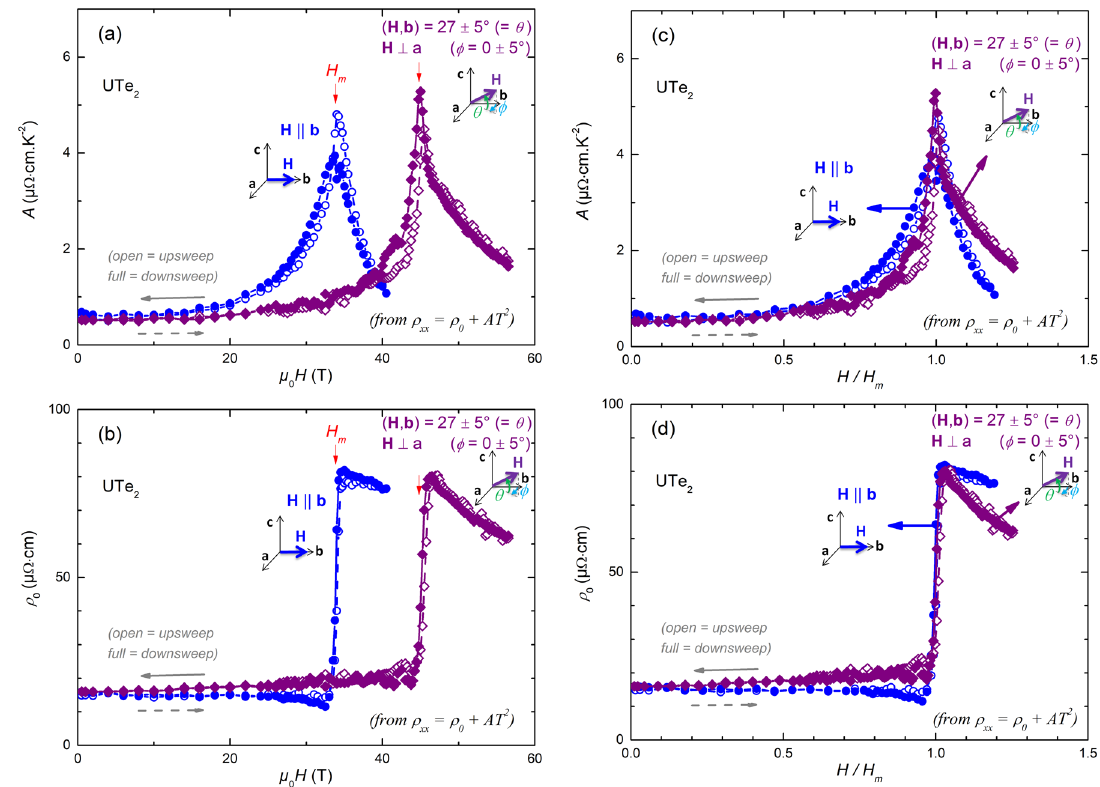
Fig. 4 Quadratic coef fi cient A and residual resistivity of UTe 2 . a Magnetic- fi eld variation of the quadratic coef fi cient A and b residual resistivity ρ 0 extracted from Fermi-liquid fi ts to the electrical resistivity of UTe 2 in a magnetic fi eld H || b and in a magnetic fi eld H tilted by 27 ± 5° from b in the ( b , c ) plane. Plots of c A and d ρ 0 versus H / H m for the two fi eld-directions. Data are presented for both fi eld-upsweeps and downsweeps. Details about the Fermi- liquid fi ts are given in Supplementary Note 1 and Supplementary Fig.